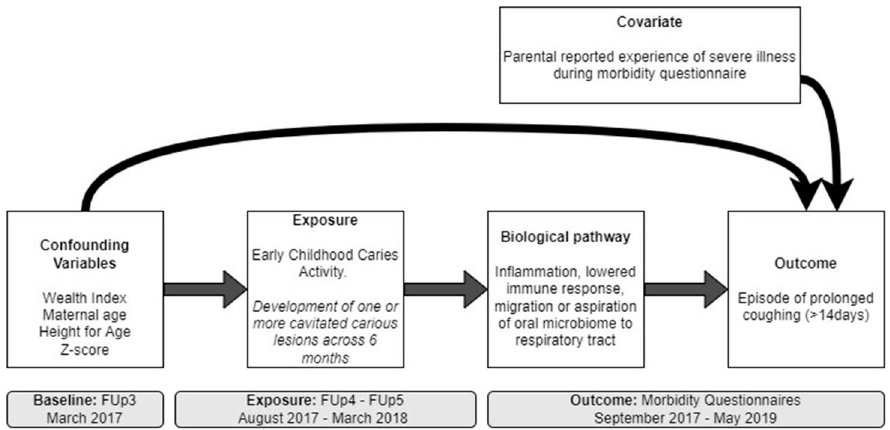
Figure 2. Directed acyclic graph for the relationship between caries exposure and episodes of prolonged cough. Abbreviations: FUp = Follow-up.